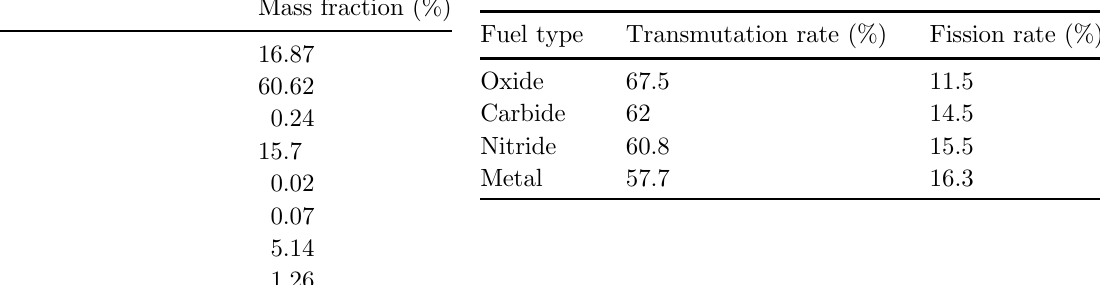
Table 4. Effect of the fuel type for a cell with 6.5% Am, averaged over the results for the three coolant types.